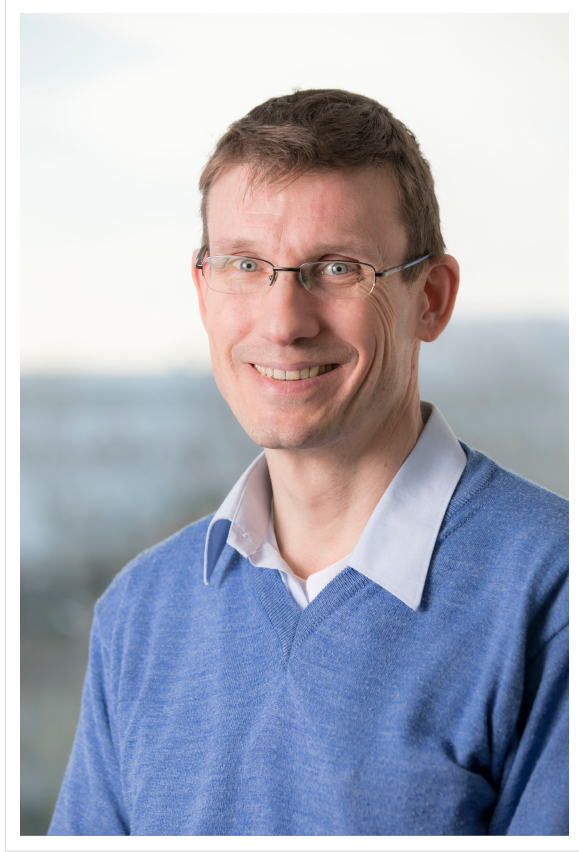
Figure 1: Carsten Schmuck.